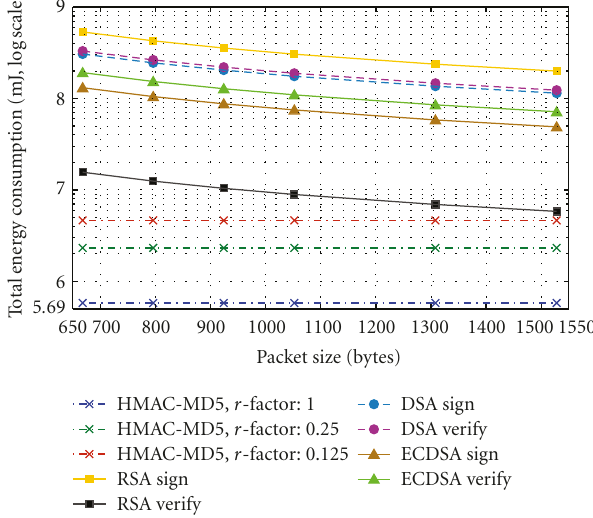
Figure 14: Comparison of total energy required for authenticating 500MB data on iPAQ H3670.